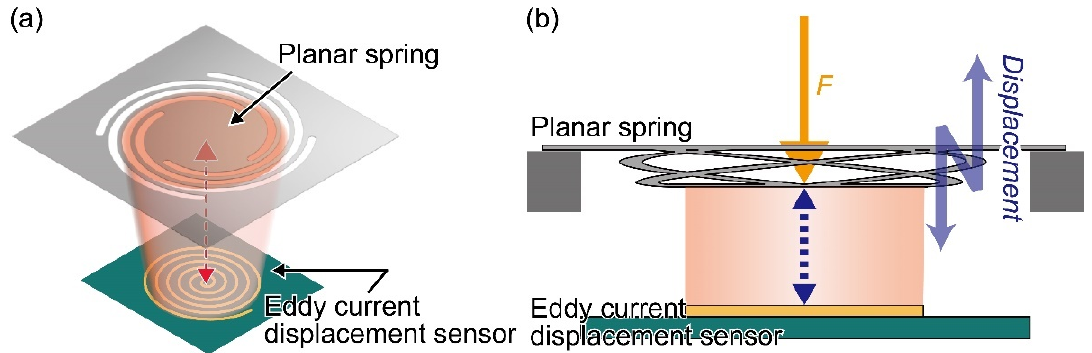
Figure 1. ( a ) Concept of the proposed force plate. This force plate consists of a planar spring and an eddy current displacement sensor. ( b ) Side view of the proposed force